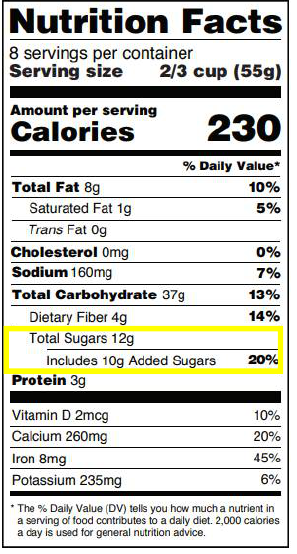
Figure 1. The new Nutrition Facts label with line designated for added sugar indented directly below “Total Sugars” [13].